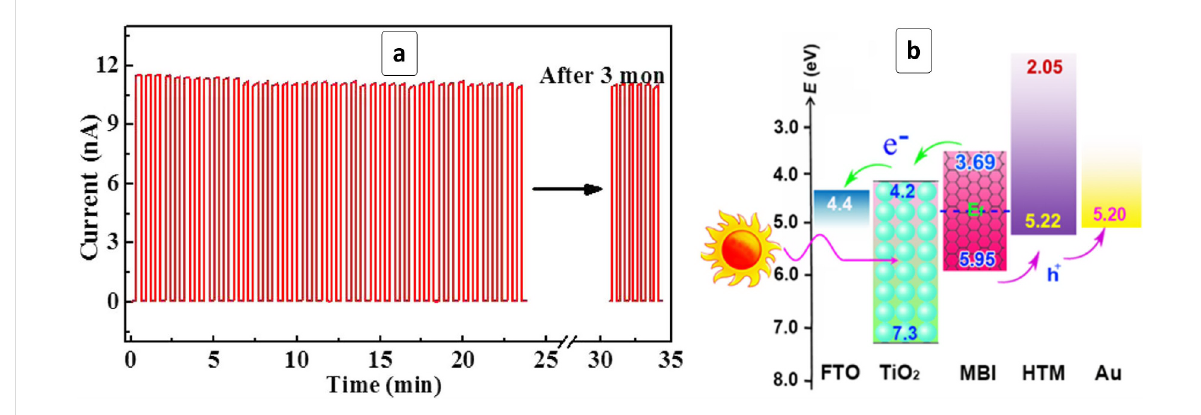
Figure 11: (a) Cyclic photoresponse of a red light photodetector based on CsBi 3 I 10 HP with a freshly prepared photosensitive layer and after the three months of storage (last five cycles). Reprinted with permission from [169], copyright 2017 American Chemical Society. (b) Energy diagram of a solar cell based on MABI (MBI) HP, mesoporous TiO 2 ETL and Spiro-OMeTAD HTL. Reprinted with permission from [84], copyright 2017 American Chemi- cal Society.